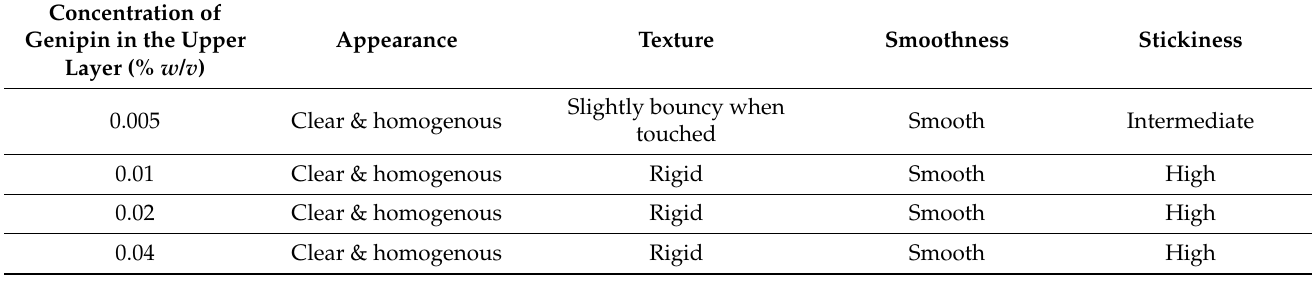
Table 3. Physical characteristics of crosslinked gelatin (3% w / v ) hydrogel.